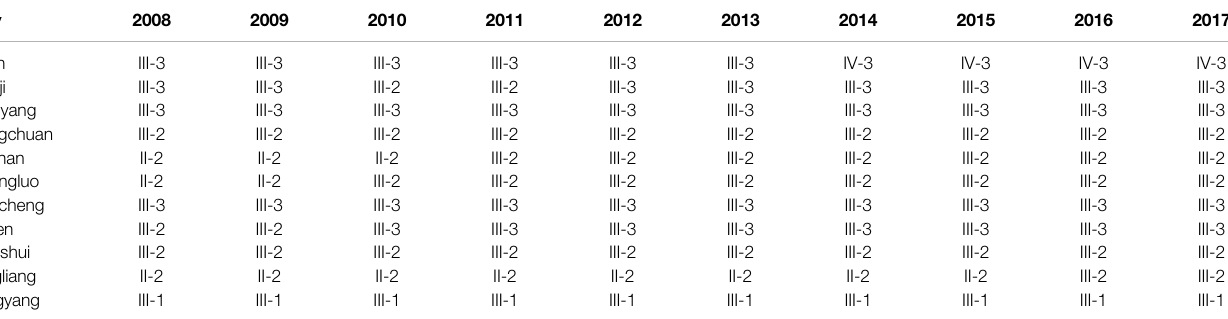
TABLE 5 | New-type urbanization and ecological environment coordination degree classi fi cation tables 2008 –